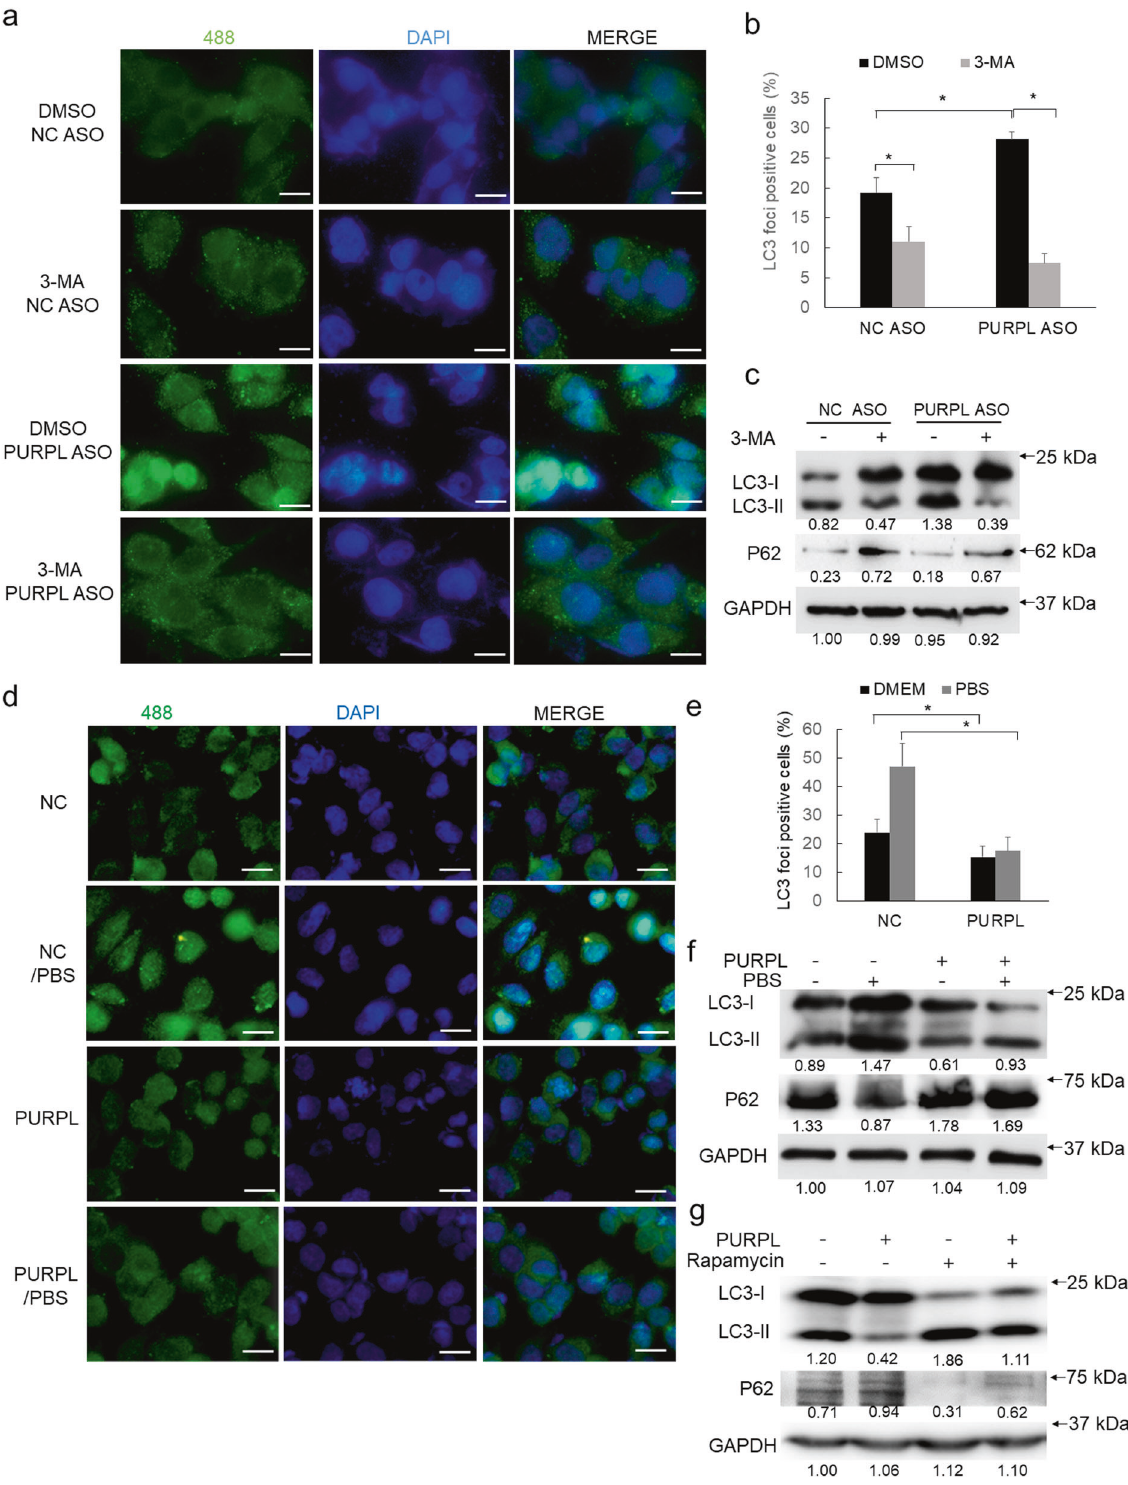
Fig. 4 Validation of PURPL ’ s role in regulating autophagy. a , b The PURPL-regulated autophagy was validated in autophagy inhibitor 3-MA- treated (5 mM for 5 h) melanoma cells following PURPL knockdown by ASO mix (ASO1:ASO2 in 1:1 ratio) using LC3 staining. c LC3B and P62 protein was detected after PURPL knockdown and 3-MA treatment by western blot, GAPDH was used as loading control. d , e The PURPL- regulated autophagy levels in melanoma cells following PURPL overexpression was evaluated by LC3 staining. PBS-treated melanoma cells were used as positive control for autophagy induction. f LC3B and P62 protein was detected after PURPL overexpression and PBS treatment by western blot, GAPDH was used as loading control. g LC3B and P62 protein was detected after PURPL overexpression and Rapamycin treatment by western blot, GAPDH was used as loading control. Scale bar, 100 μ M. * p < 0.05, ** p < 0.01, *** p <